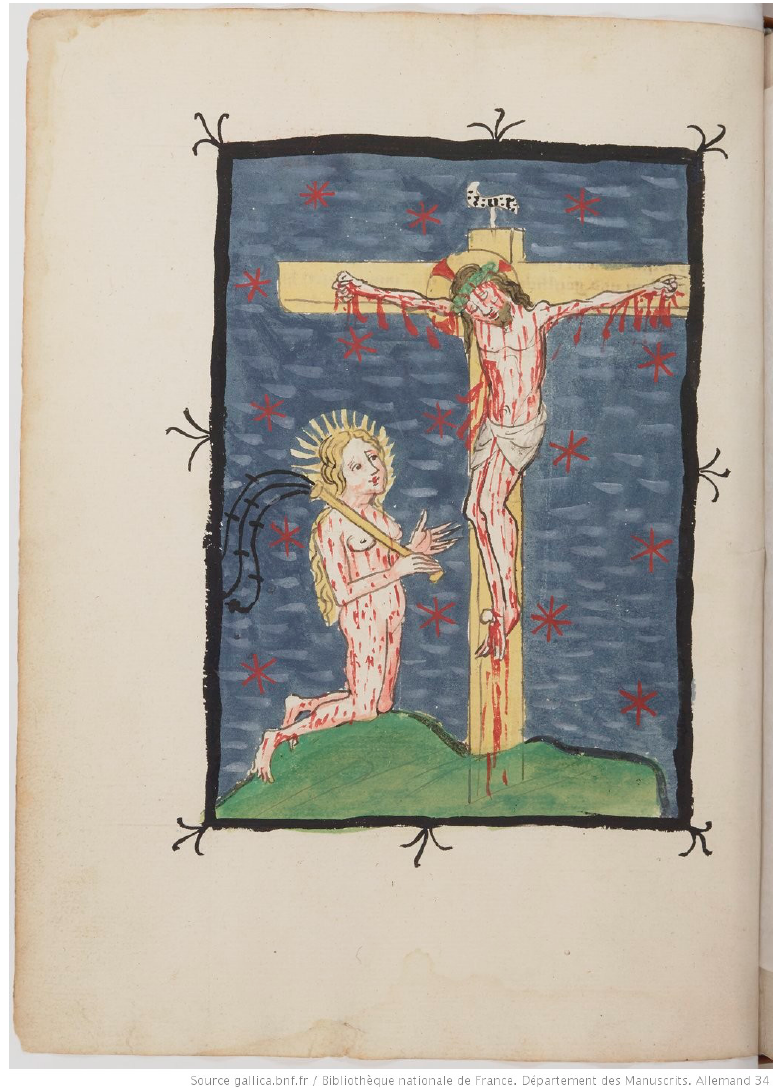
Figure 2. Caterina as a penitent child, the Geistliche Rosengarten , c. 1430; Paris, BnF, MS allemand 34, f. 4v (Source: gallica.bnf.fr/ BnF).